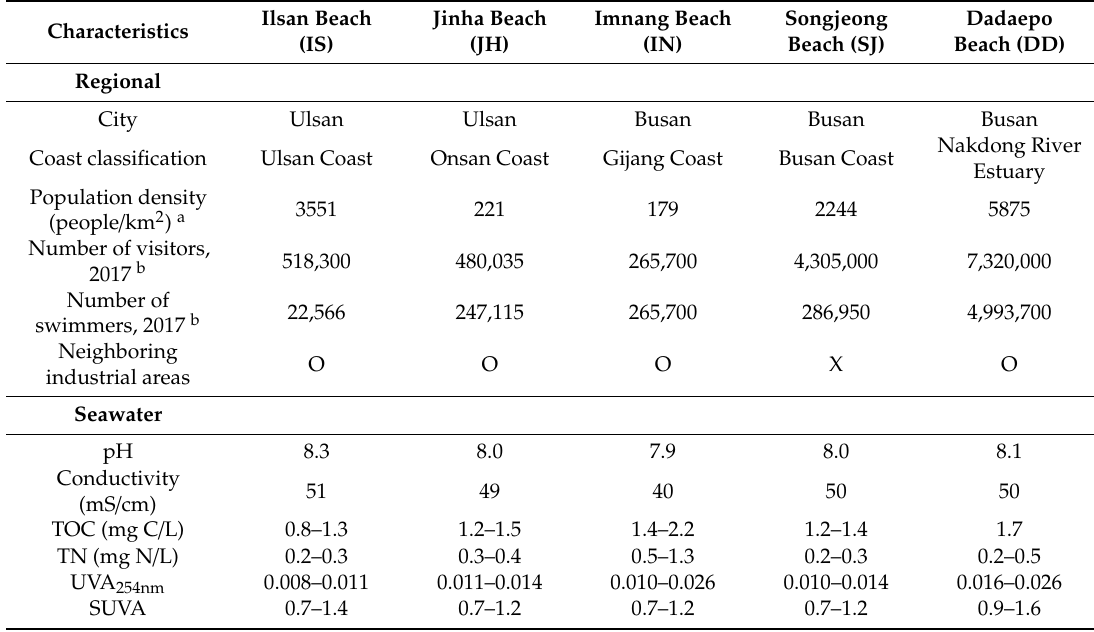
Table 1. Basic information on the sampling